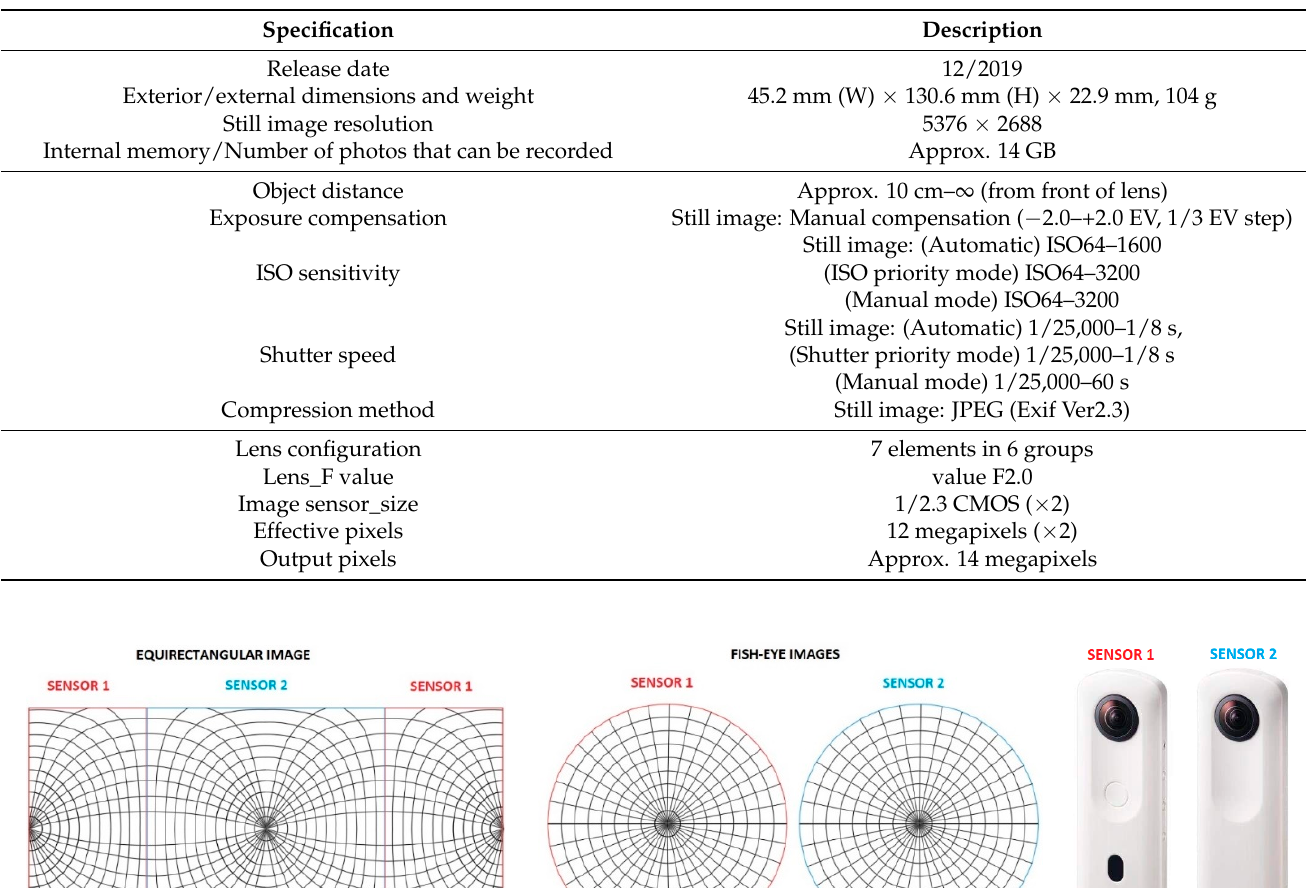
Table 2. Technical features of Ricoh Theta SC2.